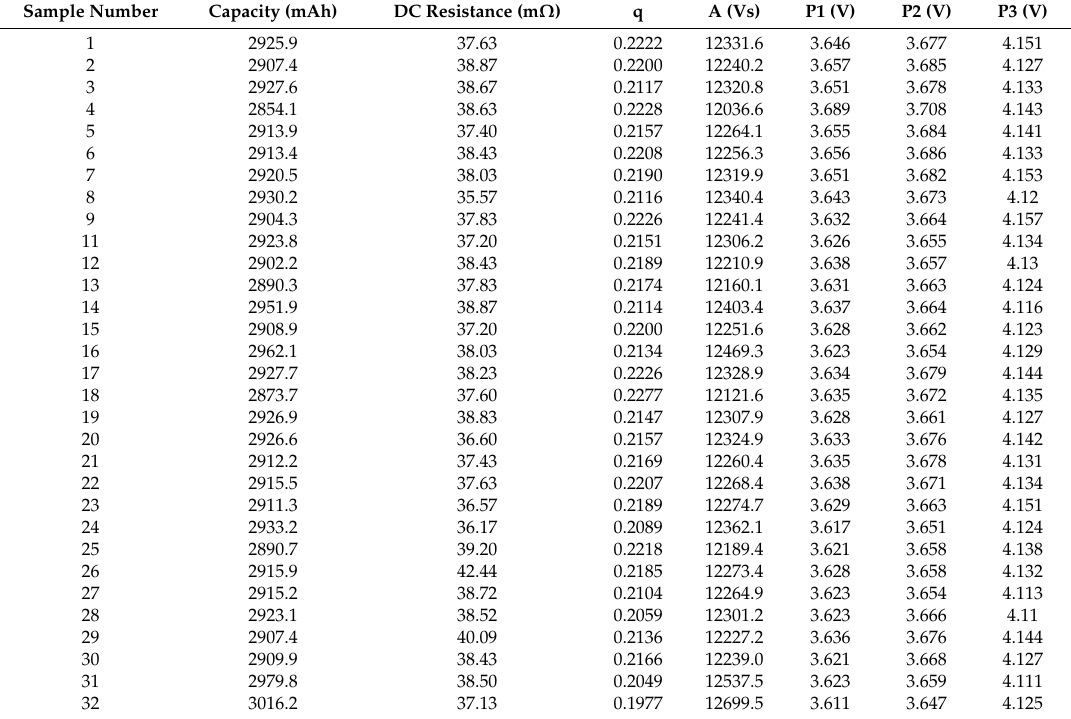
Table 5. Consistency features of cells sample after vibration